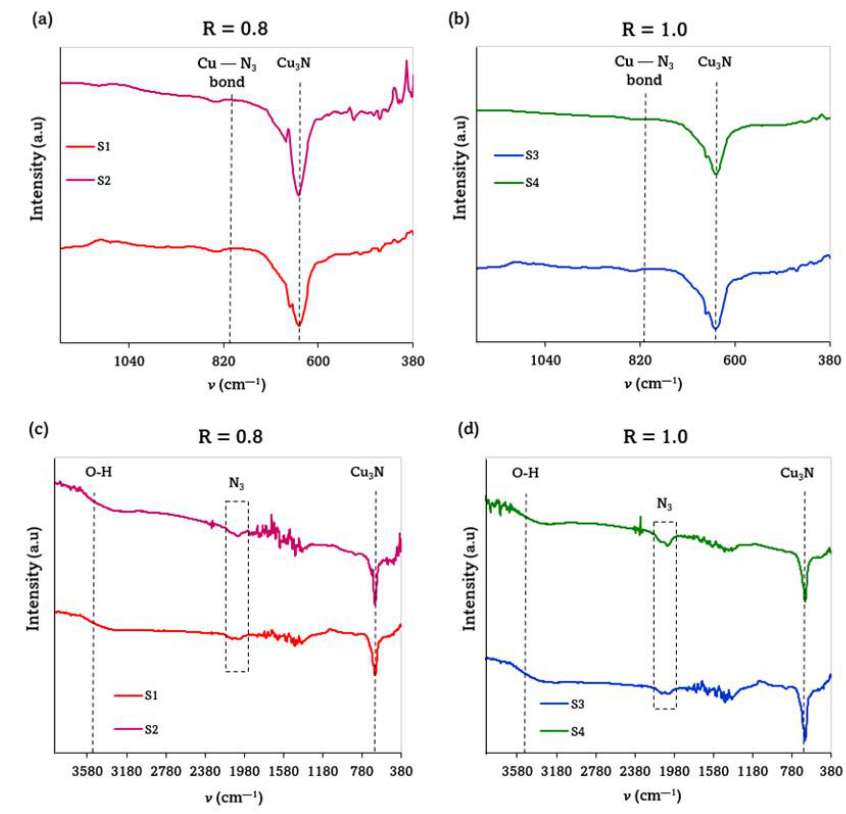
Figure 5. FTIR spectra of the Cu 3 N films deposited in ( a , c ) an N 2 + Ar gas mixture and ( b , d ) a pure N 2 atmosphere.